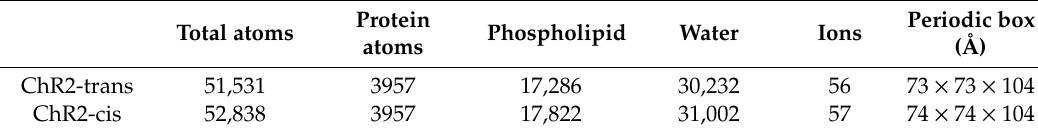
Table 1. Detailed information of the simulation system of ChR2-trans and ChR2-cis. Total atoms